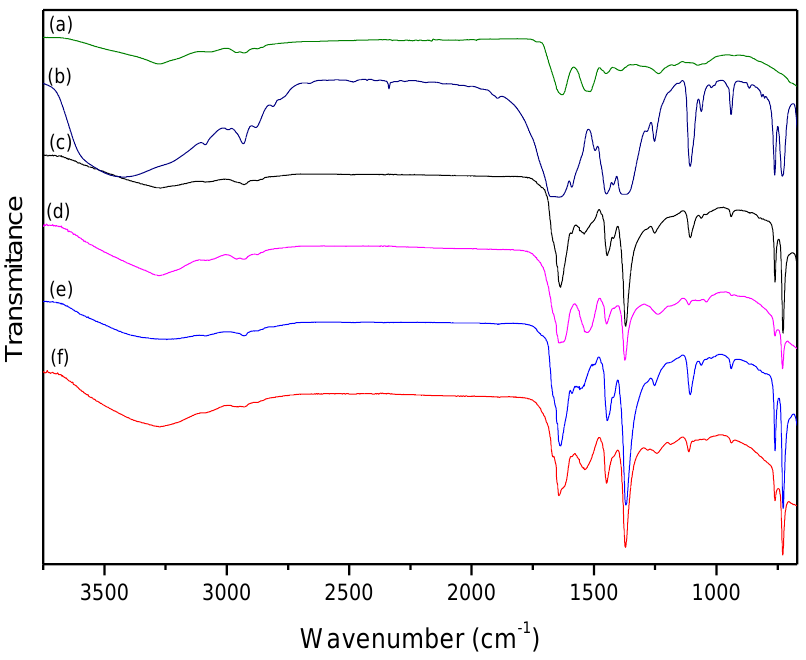
Figure 2. FTIR-ATR of: ( a ) woolen fabric (untreated); ( b ) HKUST-1; wool@HKUST-1 synthesis of: ( c ) 24 h; ( d ) 24 h washed; ( e ) 48 h; and ( f ) 48 h washed.